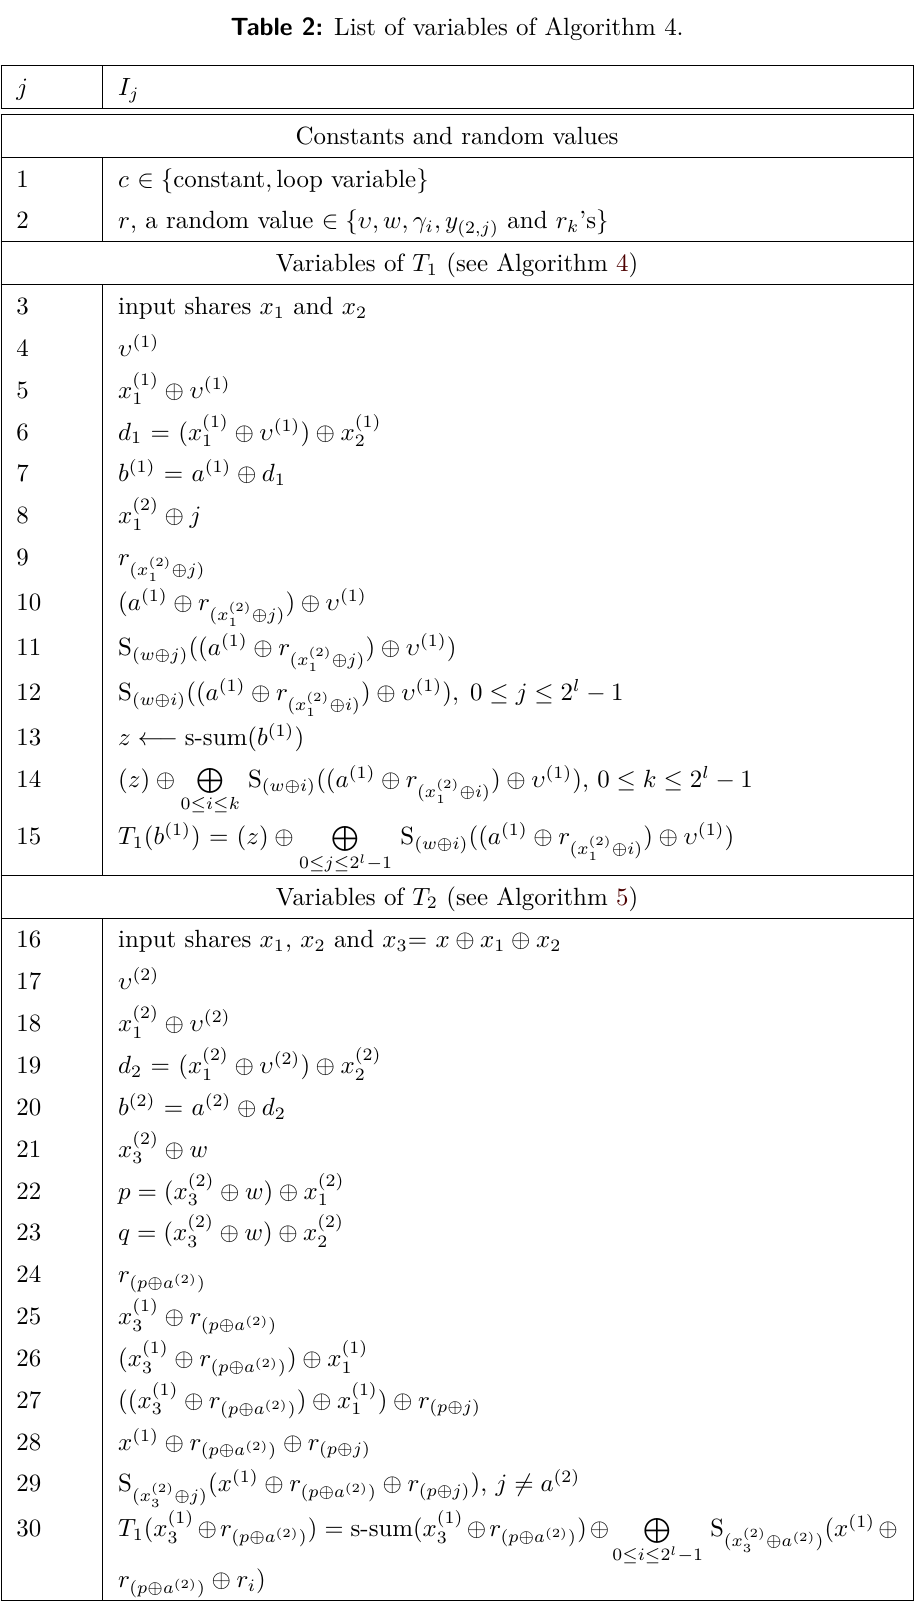
Table 2: List of variables of Algorithm